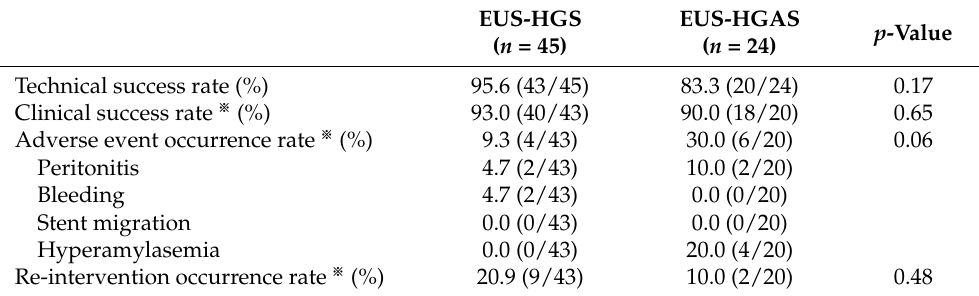
EUS-HGS EUS-HGAS p -Value ( n = 45) ( n = 24)